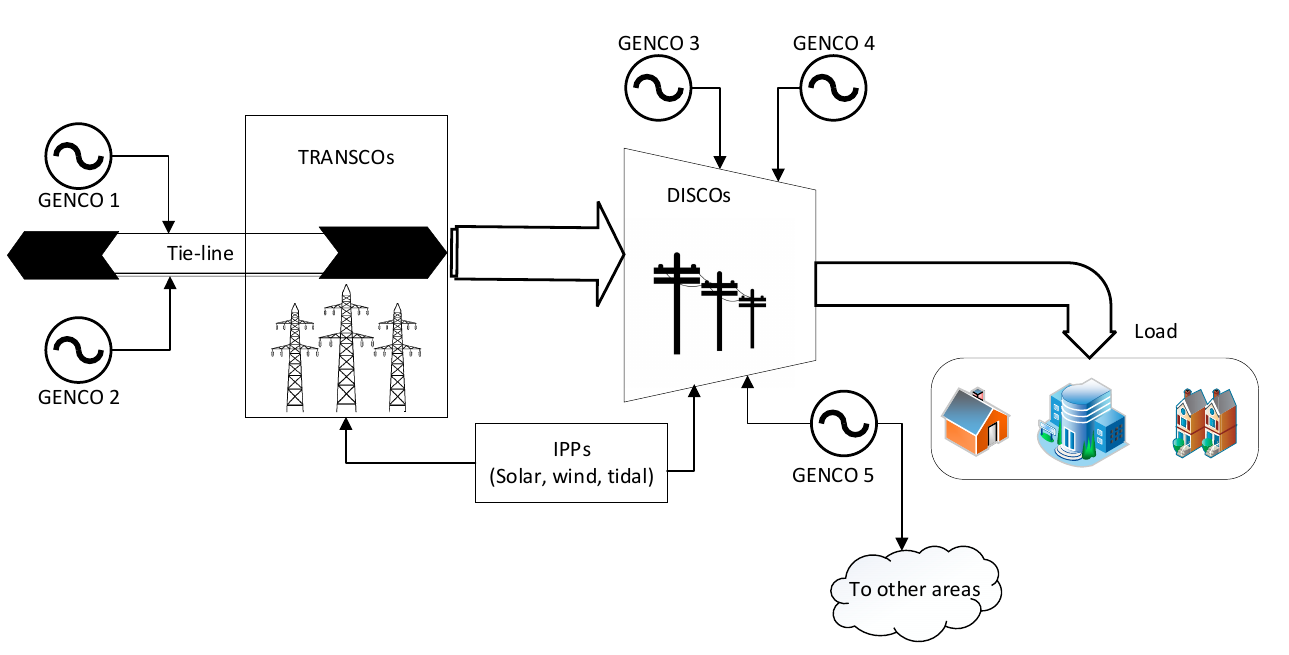
Figure 2. Control area structure of the deregulated power system.